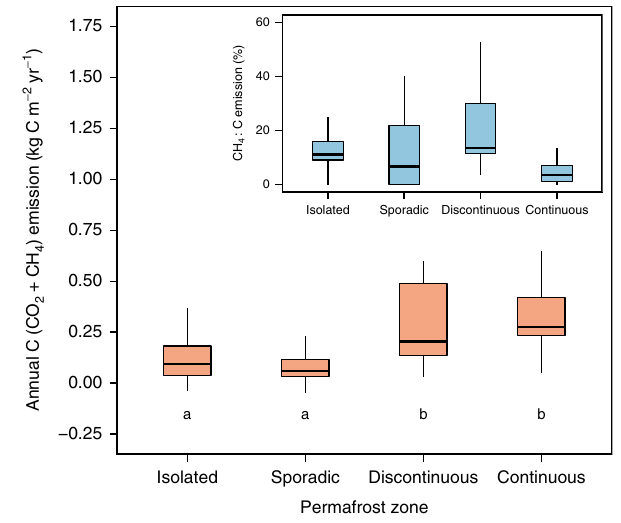
Fig. 3 Annual C (CO 2 + diffusive CH 4 ) emission across different permafrost zones. Annual C emission is greater in colder permafrost-rich regions compared to warmer permafrost-poor regions (see Fig. 1 for the geographical location of different permafrost zones). The inset shows the percent of diffusive CH 4 emission in annual C emission across different permafrost zones. Boxes are bound by 25th and 75th percentiles, whiskers show 1.5 interquartile range. Solid line represents median values. Positive values indicate outward fl ux from the lakes into the atmosphere. Permafrost zones that share a letter are not signi fi cantly different. We removed 3 outliers on the main plot and 5 outliers on the inset to visually improve the graph, but used the complete dataset for statistical analyses.